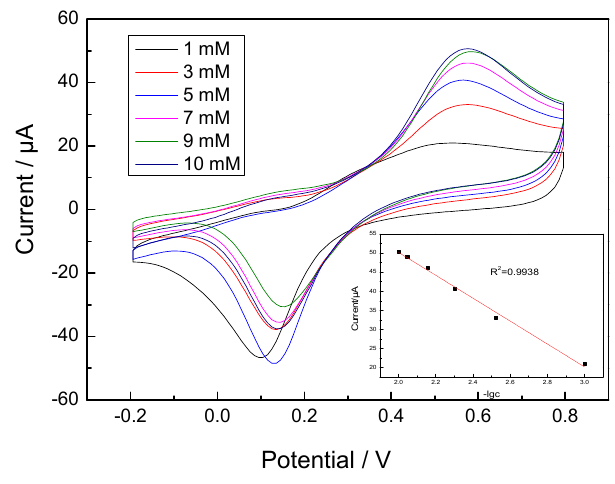
Figure 7. CVs of the GOx/HTNTs/Ti electrode in PBS (pH = 7.4) containing different concentrations of glucose at a scan rate of 10 mV ∙ s − 1 . The inserted graph showed the relationship between the peak current under the potential of + 0.55 V and the negative logarithm of the glucose concentration.